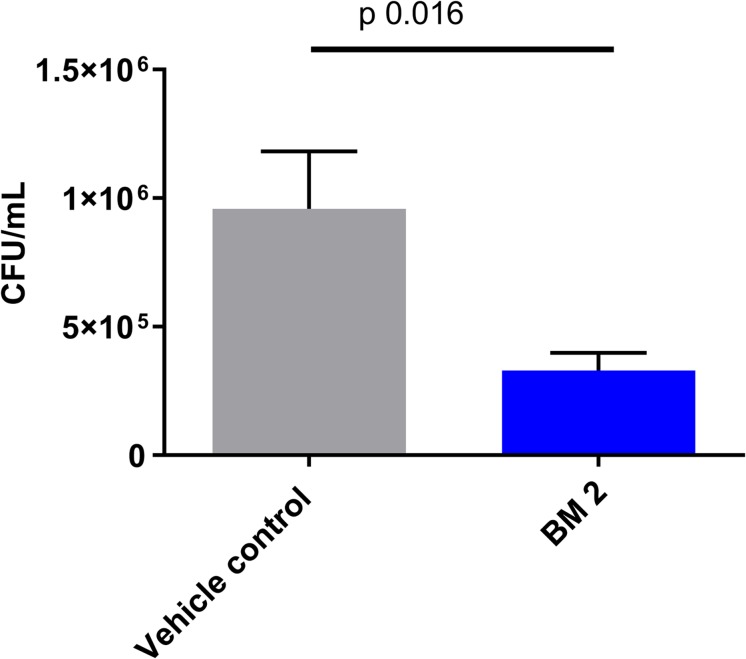
CFU in the lungs of BALB/c mice infected intra-nasally with M. tuberculosis H37Rv and treated with six doses of peptoid BM 2 (5 mg/kg per dose) over a 2 weeks period via the intra-tracheal route. The CFU in the lungs of the mice showed a significant reduction in the bacterial load (p = 0.016) following treatment with BM 2 compared to the untreated control group. Data is representative of five mice for each group. Mann–Whitney test was applied to determine statistical differences between the two groups.